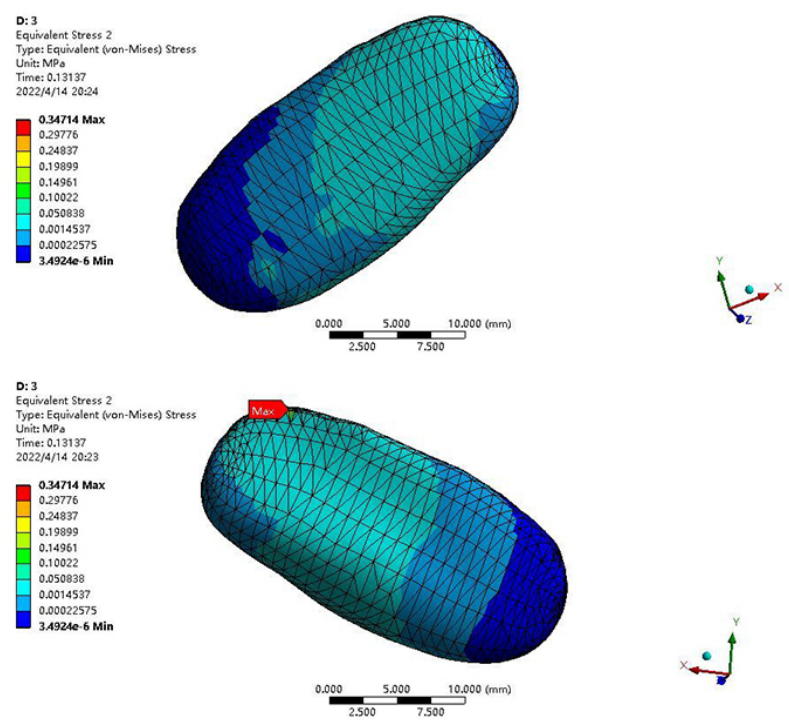
Fig. 5. Stress change at the start of the subacromial bursa holding stage.